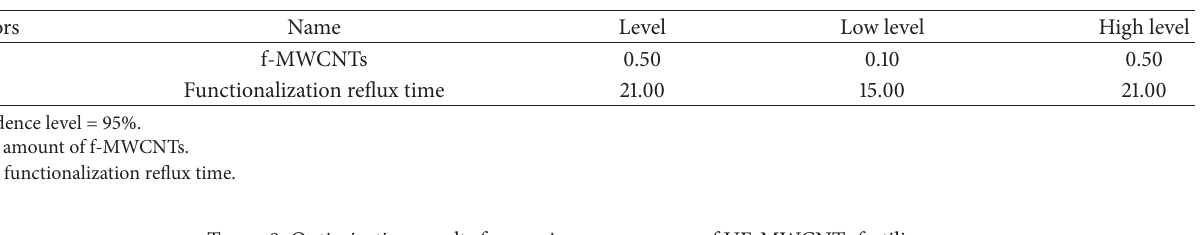
Table 9: Optimization results for maximum responses of UF-MWCNTs fertilizer.